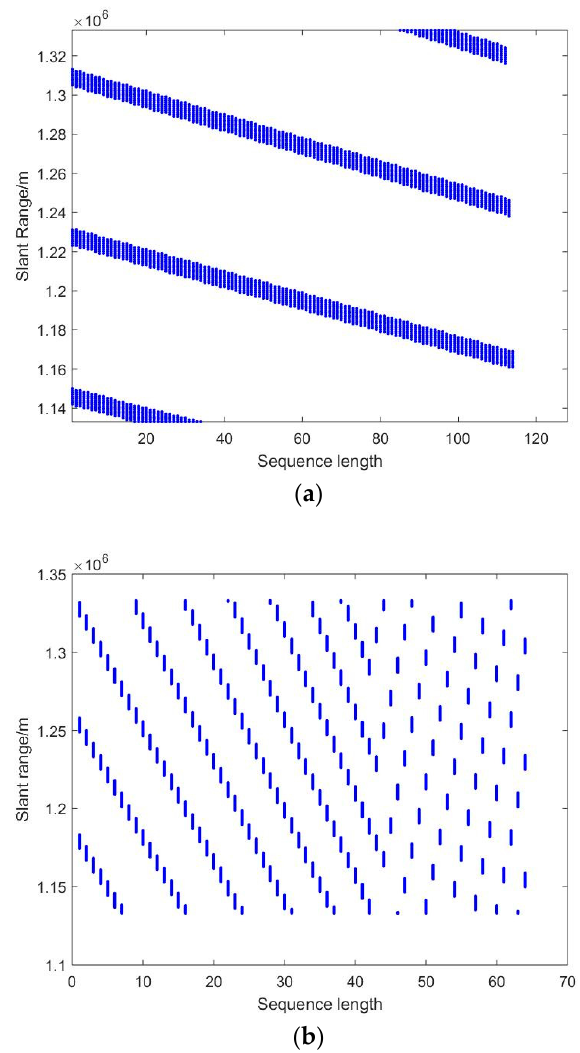
Figure 2. Blind ranges location for a given parameter of different PRI variations: ( a ) Slow linear PRI variation; ( b ) fast linear PRI variation.